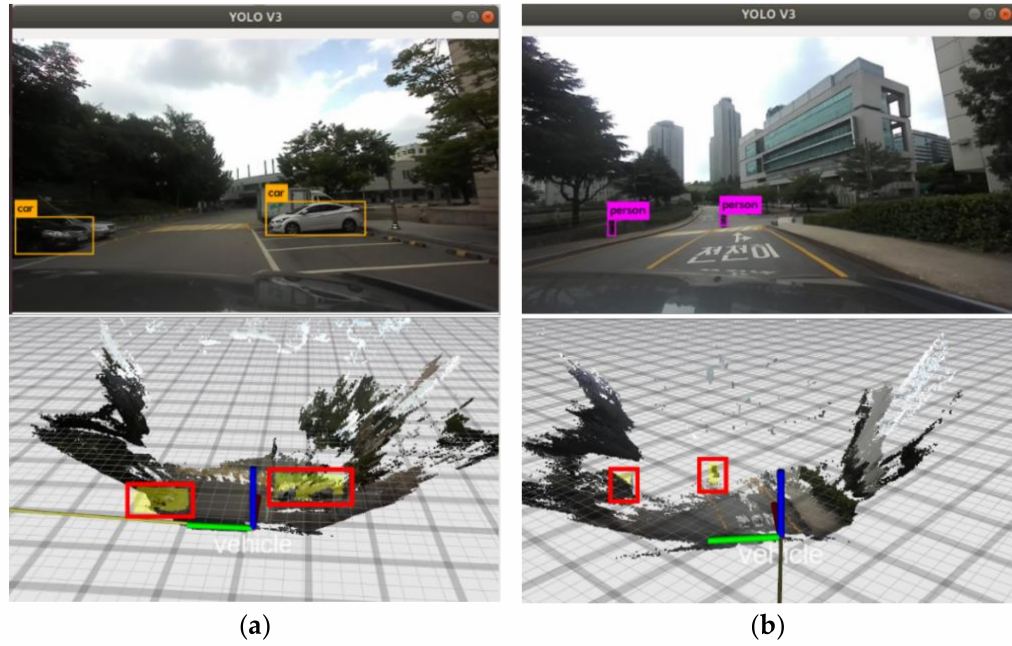
Figure 8. 3D object detected based on vehicle coordinates. ( a ) Vehicle. ( b )